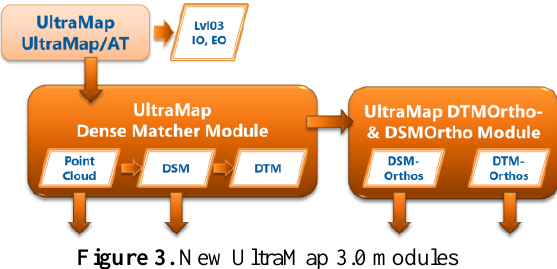
Figure 3. New UltraMap 3.0